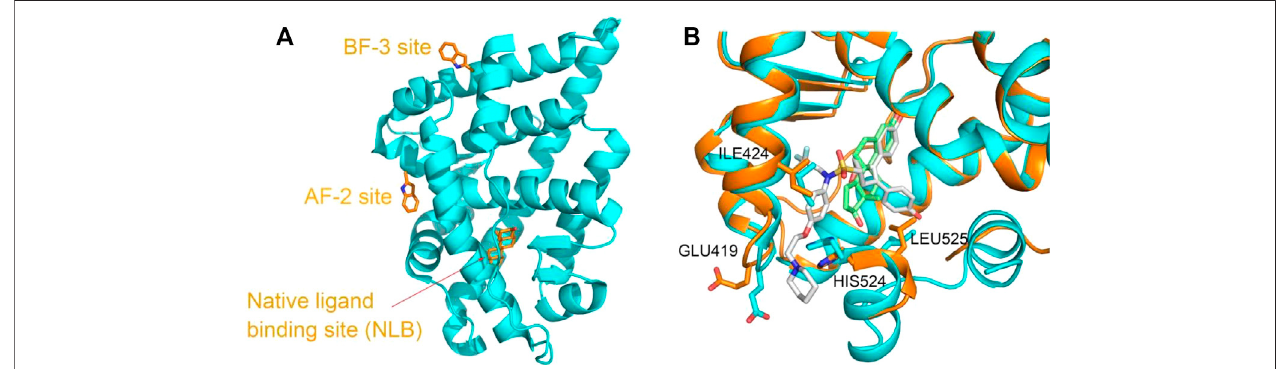
FIGURE 1 | (A) Three binding sites in the ligand-binding domain of the AR depicted based on PDBID 2POI and (B) the ligand-binding site fl exibility of ER α in complex with different compounds, estradiol ((8R,9S,13S,14S,17S)-13-methyl-6,7,8,9,11,12,14,15,16,17-decahydrocy clopenta[a]henanthrene-3,17-diol) and 7AI ((1S,2R,4S)-5,6-bis(4-hydroxyphenyl)-N-{4-[2- (piperidin-1-yl)ethoxy]phenyl}-N-(2,2,2-tri fl uoroethyl)-7-oxabicyclo[2.2.1]hept-5-ene-2-sulfonamide) (structures from PDBID 5GS4 and 7RRX). Proteins are represented in a cartoon model, and compounds or residues, in a stick model. In (B) , proteins from 5GS4 and 7RRX are colored in cyan and orange, and the compounds estradiol and 7AI are colored in green and gray, respectively. Residues undergoing considerable conformation changes, such as ILE 424, GLU419, HIS524, and LEU525 are depicted in the stick